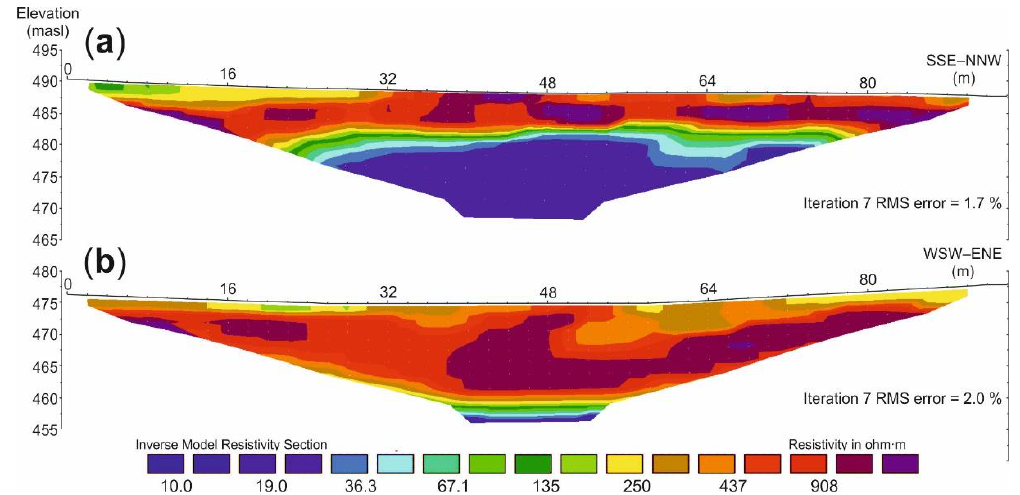
Figure 3. ( a ) ERT cross-section P1. The interpreted pyroclast layer is narrow and the depth of the low-resistivity ignimbritic substrate (<80 ohm-m) appears at about 5 m deep; ( b ) ERT cross-section P3. The inferred pyroclast layer is thicker and the low-resistivity ignimbritic substrate is located more than 15 m deep.